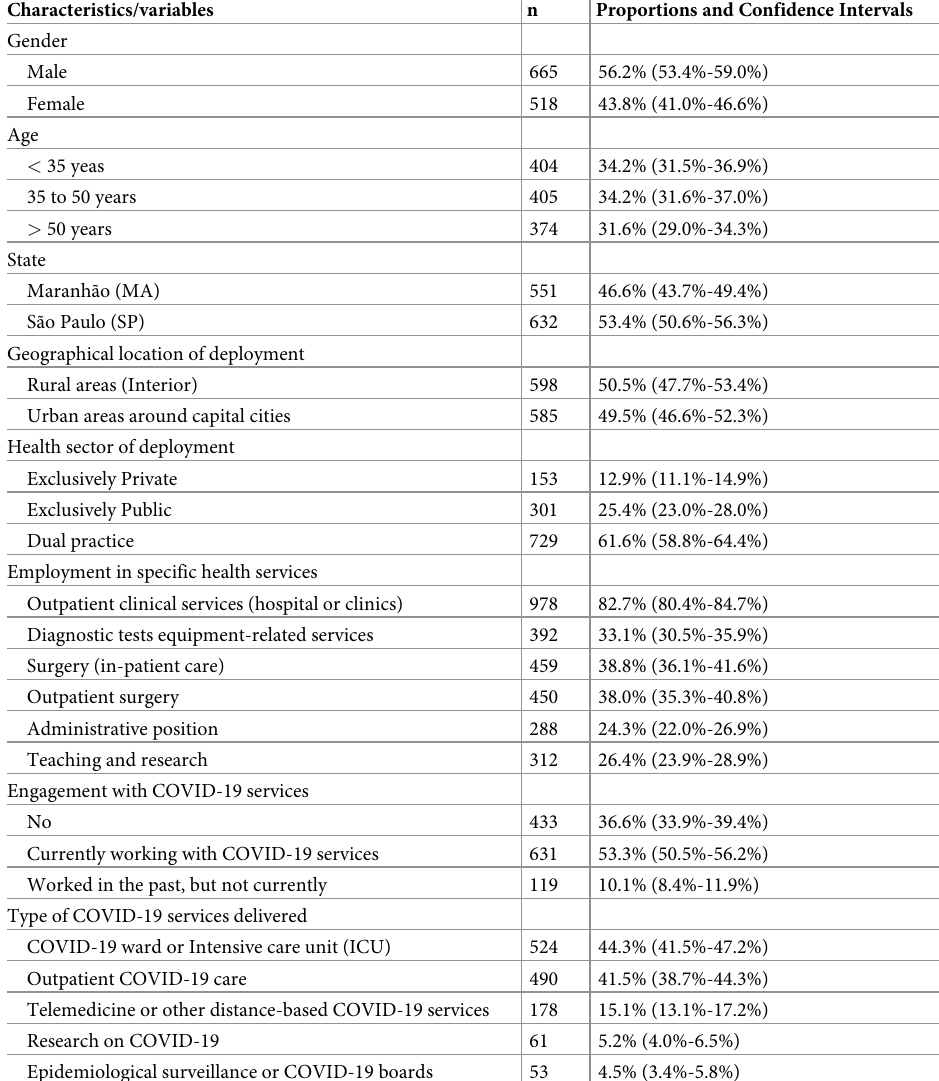
Table 2. Characteristics of physicians in the survey